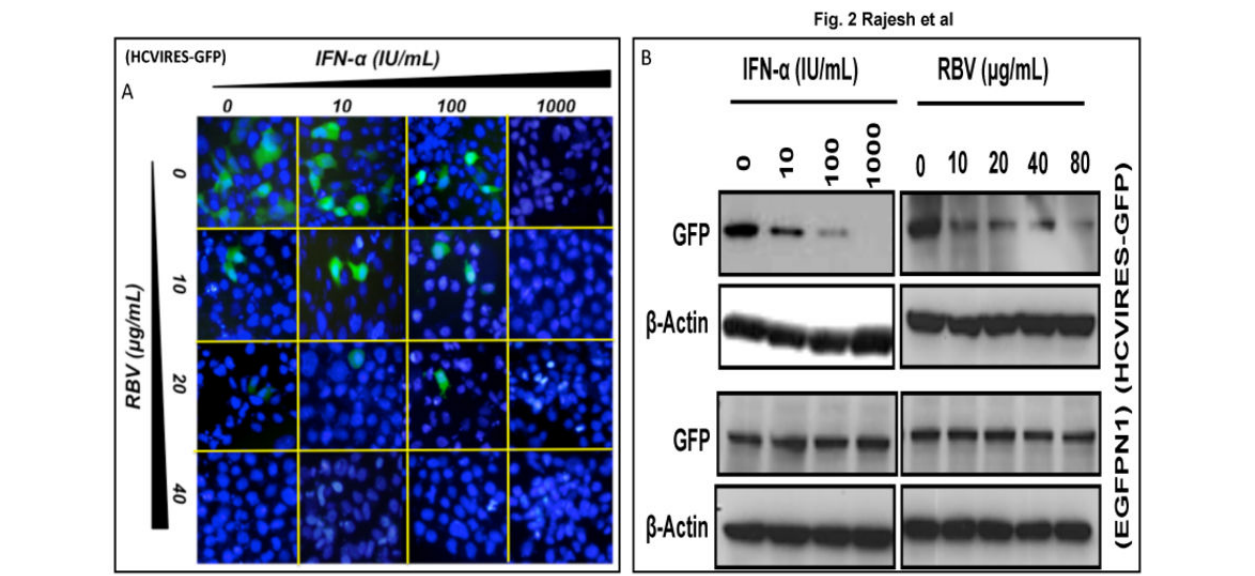
Figure 2. IFN-α and RBV each inhibited the internal ribosome entry site (IRES) mediated translation of green fluorescence protein (GFP). Huh-7 cells were infected with T7-expressing adenovirus. After 2 hrs, HCV IRES-GFP plasmid was transfected and then treated with indicated concentration of IFN-α and RBV. ( A ) HCV IRES mediated GFP expression was monitored under fluorescent microscopy. ( B ) Inhibition of GFP expression was further confirmed by Western blot analysis in both IRES and non- IRES mechanisms. β-actin is used as loading